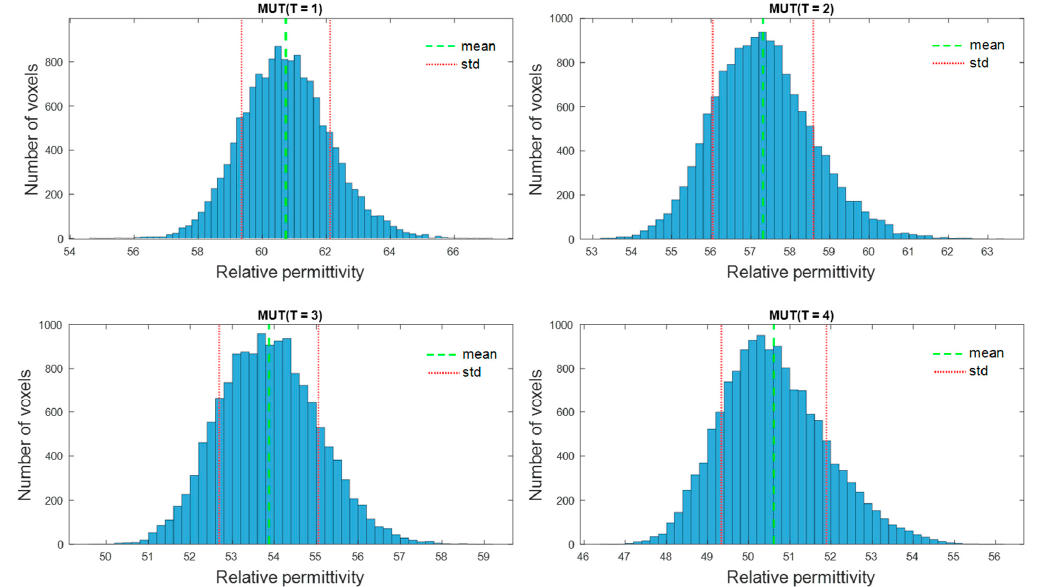
Figure 8. Distribution of the estimated relative permittivity values at 2 GHz in the 3D tumor area. Mean value is shown in green and standard deviation in red.